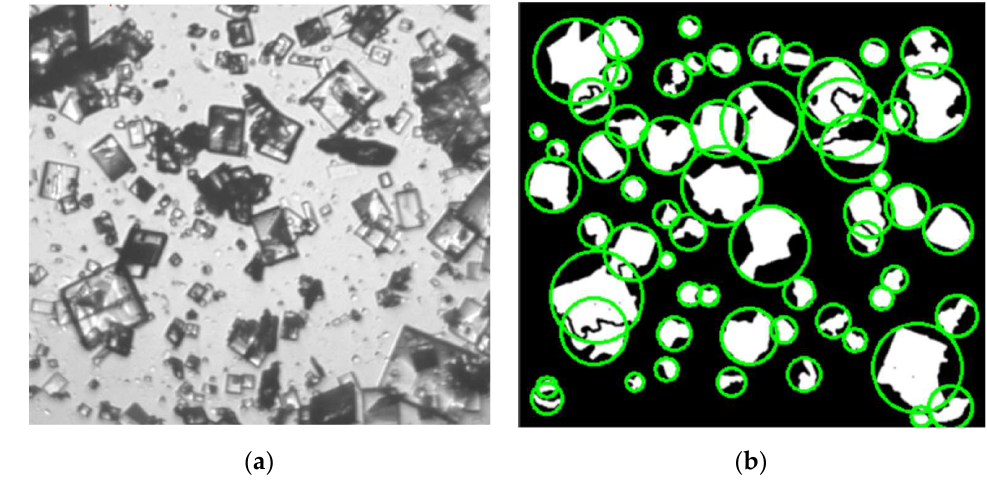
Figure 8. Analytic result of another image: ( a ) the in situ captured image; ( b ) size measurement.